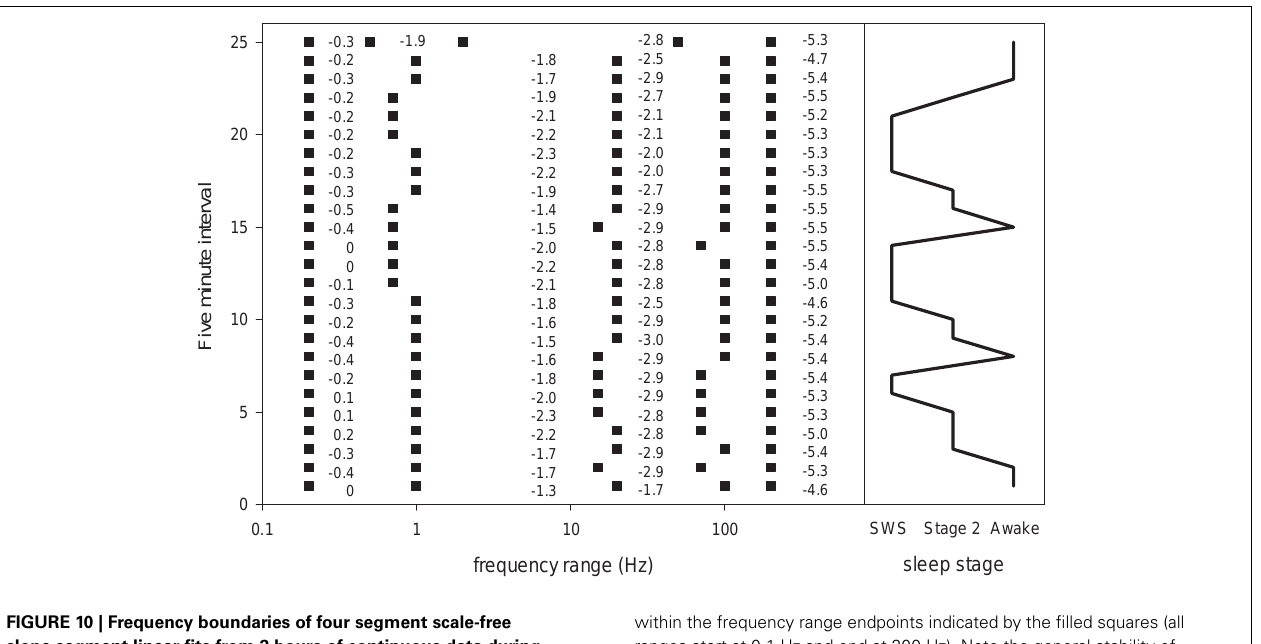
FIGURE 10 | Frequency boundaries of four segment scale-free slope segment linear fits from 2 hours of continuous data during state changes in subject 1. Y axis shows frequency boundaries from 25 consecutive five minute intervals. X axis shows log frequency. Numbers indicate the value of the slope for each five minute interval